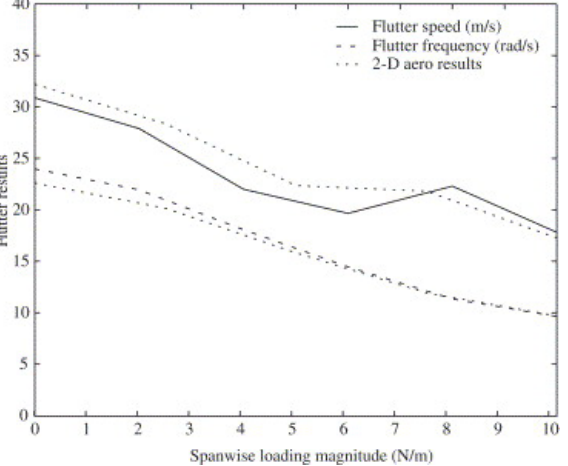
Figure 1. The effect of geometric nonlinearities on flutter [1]. Reprinted from Patil, M.J.; Hodges, D.H. On the importance of aerodynamic and structural geometrical nonlinearities in aeroelastic behavior of high-aspect-ratio wings. J. Fluids Struct. 2004 , 19 , 905–915, with permission from